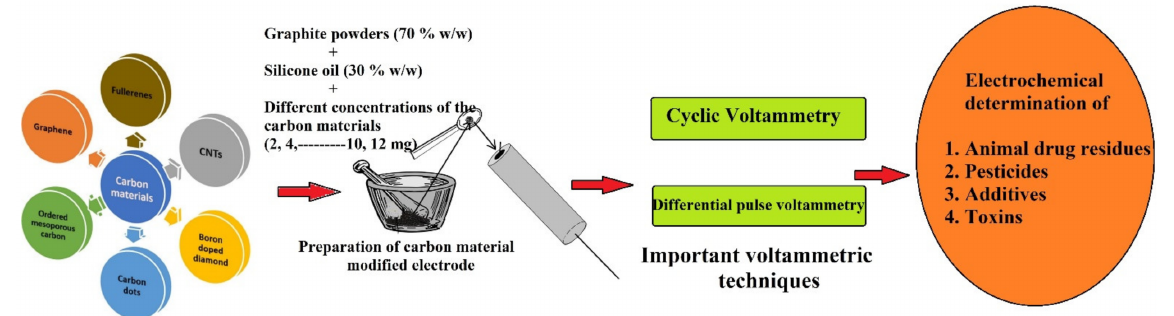
Figure 1. Types of carbon materials and the overview of the